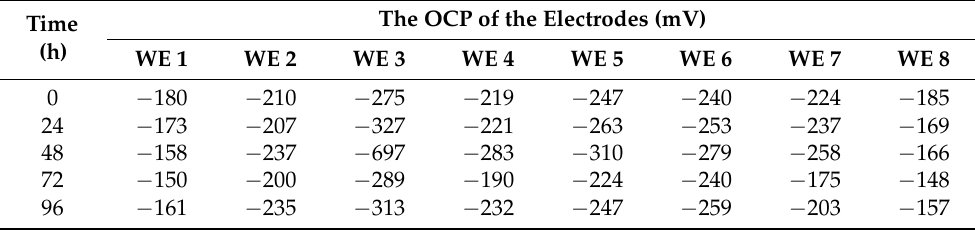
Table 2. The OCP of the electrodes at different